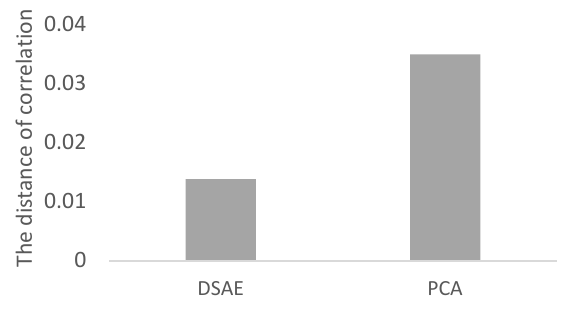
Figure 9. Averaged distance of correlation among pairs of time-series of latent features extracted from D7 to D12 by using PCAs and DSAEs.